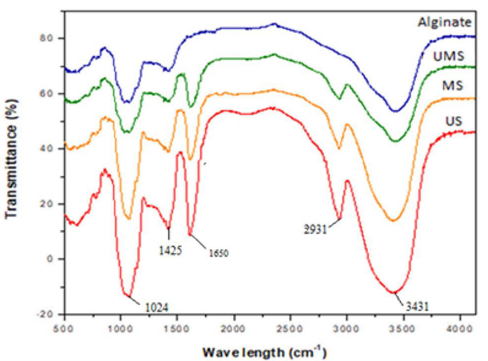
Figure 3. FT-IR spectra of alginate and IEs in Ca-alginate beads generated with UMS treatment.